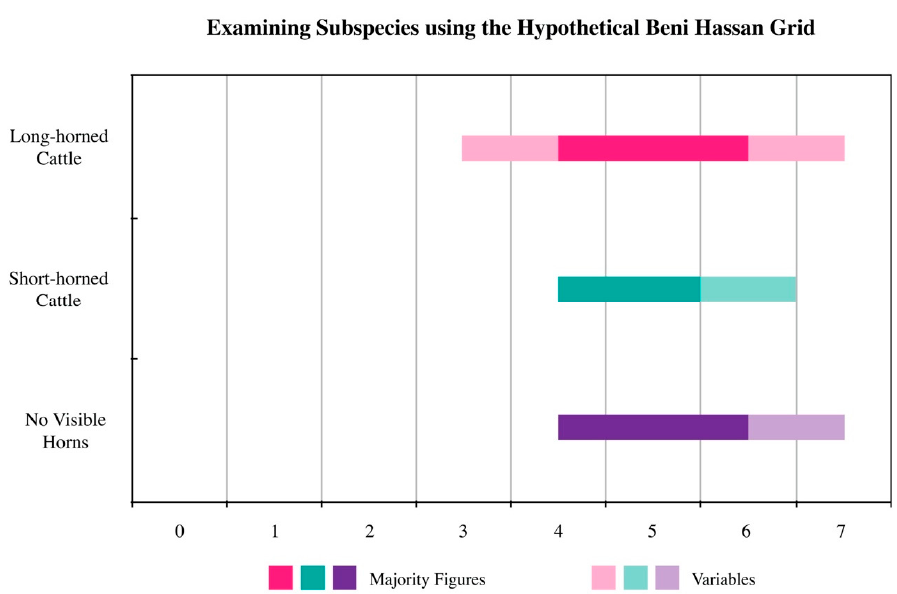
Figure 7. Examining subspecies using the hypothetical Meir grid.